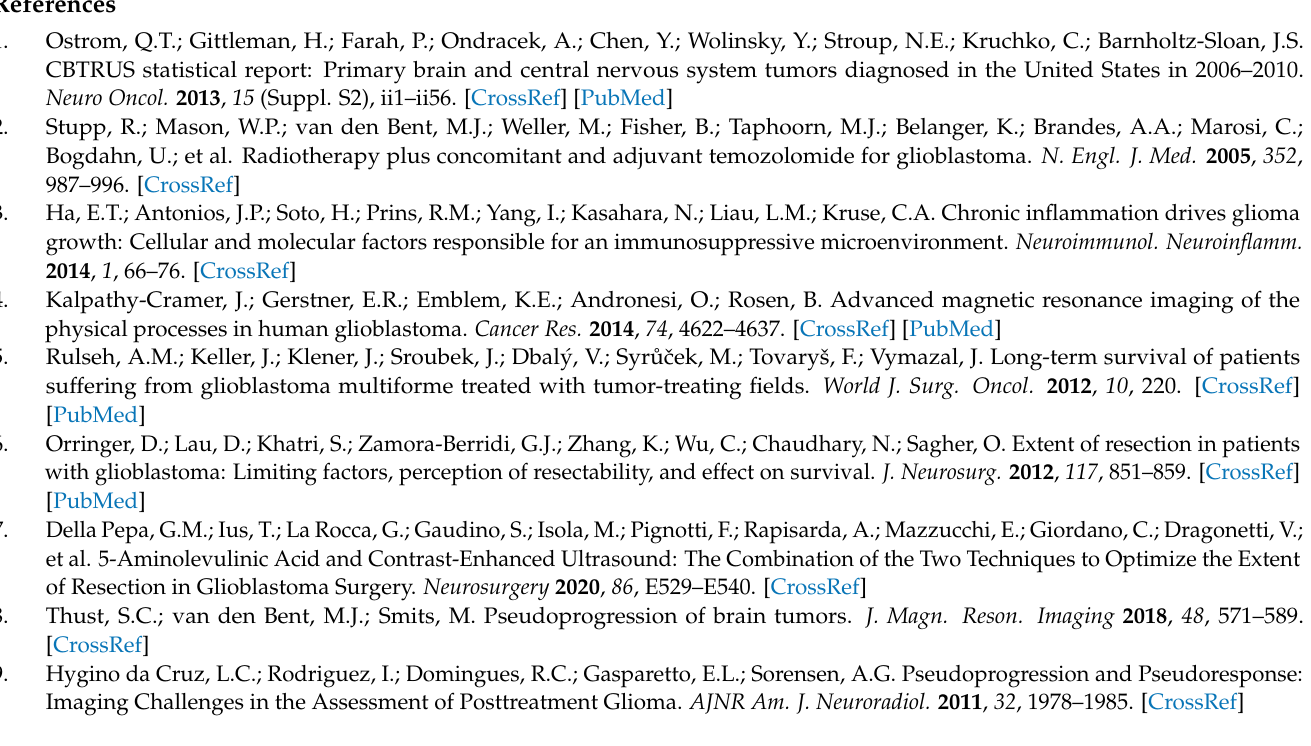
monocytes (left) and the CD14+ subsets analyzed. Figure S2: M2 monocyte subset representation according to ependymal enhancement. Figure S3: M2 monocyte subset representation according to corpus callosum infiltration. Figure S4: M2 monocyte subset representation according to midline shift. Figure S5: M2 monocyte subset representation according to macroscopic hemorrhage. Figure S6: M2 monocyte subset representation according to edema score. Figure S7: M2 monocyte subset representation according to intratumoral susceptibility signal intensity (ITSS). Table S1: GE MR imaging protocol. Table S2: Philips MR imaging